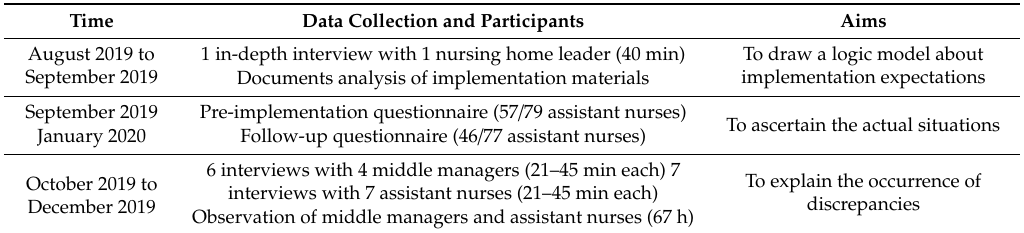
Table 2. Summary of collected